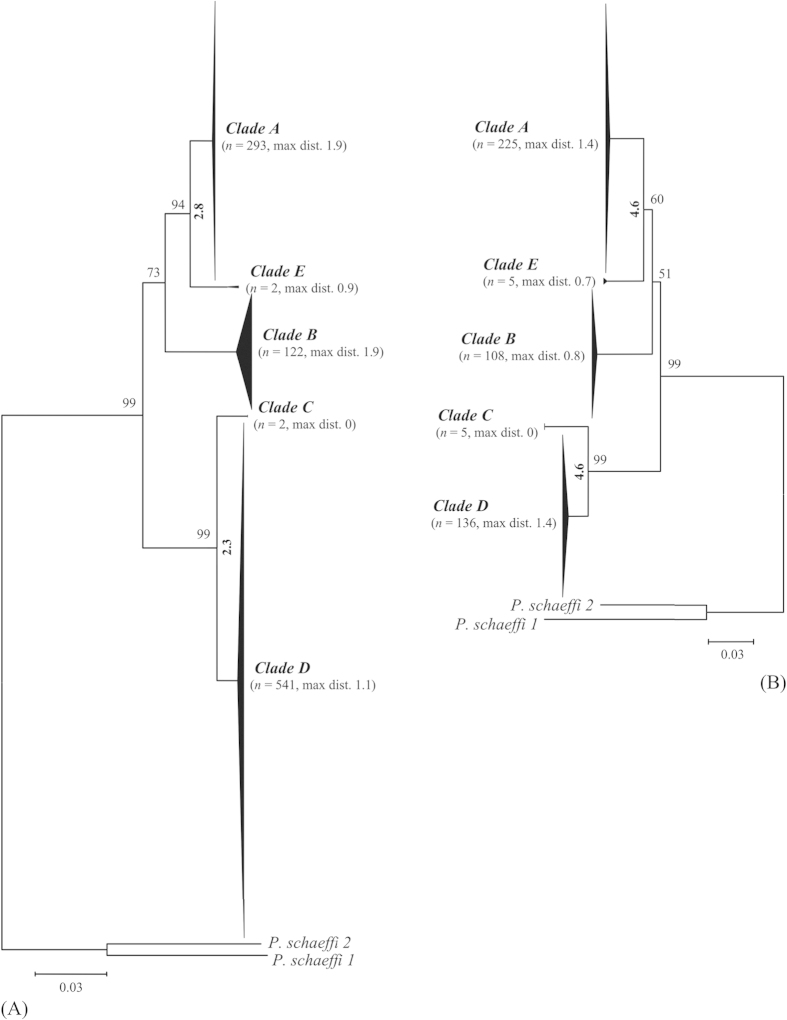
NJ cluster analysis of 960 COI (A) and 479 cytb (B) sequences from head lice.Bootstrap values (500 replicates) are shown above the branches. The scale bar shows K2P distances. The node for each clade with multiple specimens is collapsed to a vertical triangle, with the horizontal depth indicating the level of intraclade divergence. Bracketed numbers next to each clade name indicate the number of individuals analyzed and the maximum intraclade distance. Analyses were conducted in MEGA5.